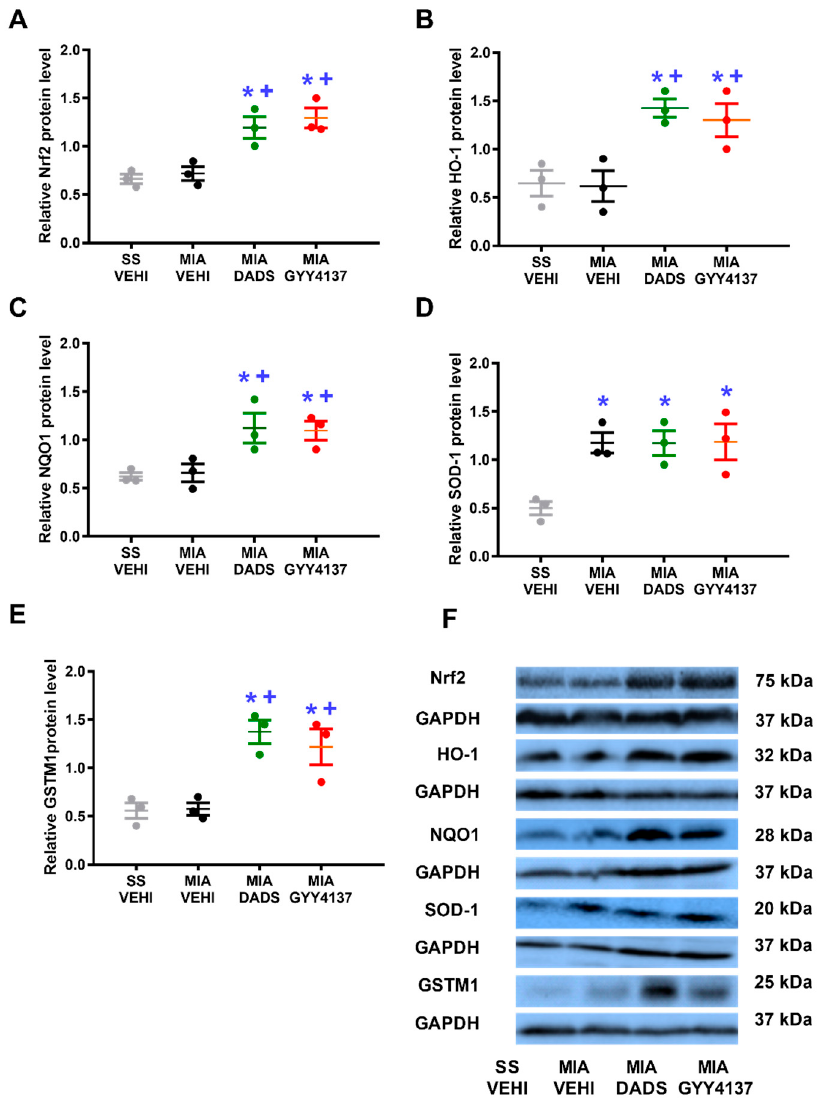
Figure 5. Effects of treatment with DADS and GYY4137 on the Nrf2, HO-1, NQO1, SOD-1, and GSTM1 protein levels in the ipsilateral DRG of MIA-injected mice. The expression of Nrf2 ( A ), HO-1 ( B ), NQO1 ( C ), SOD-1 ( D ), and GSTM1 ( E ) in DRG of MIA-injected animals treated with vehicle (MIA-VEHI), DADS (MIA-DADS) or GYY4137 (MIA-GYY4137) and of SS-injected animals administered with vehicle (SS-VEHI) are represented. All proteins are expressed relative to GAPDH levels. For each protein, * denotes significant differences vs. SS plus vehicle-treated mice and + vs. MIA plus vehicle-treated animals ( p < 0.05, one-way ANOVA; Student–Newman–Keuls test). Examples of blots for Nrf2, HO-1, NQO1, SOD-1, GSTM1, and GAPDH are shown ( F ). Results are represented as the mean ± SEM ( n = 3 samples).